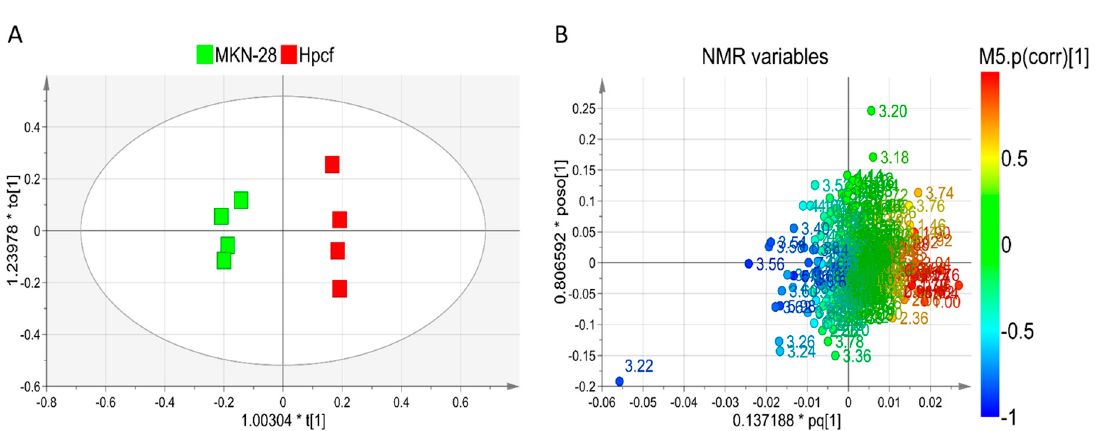
Figure 1. OPLS-DA of MKN-28 cell samples. ( A ) Scores plot showing the distinct separation between MKN-28 cells incubated (red squares) and not incubated (green squares) with Hpcf . The X-axis title represents the factor multiplied (*) the principal predictive component t[1] which better approximates the dataset variation correlated with samples classification. On the ordinate axis, the title represents the factor multiplied (*) the orthogonal component to[1] which accounts for intraclass variation. ( B ) Loadings plot of nuclear magnetic resonance (NMR) variables (chemical shift) referred to metabolites responsible for between-classes separation and characterized by | p (corr)| value > 0.7.